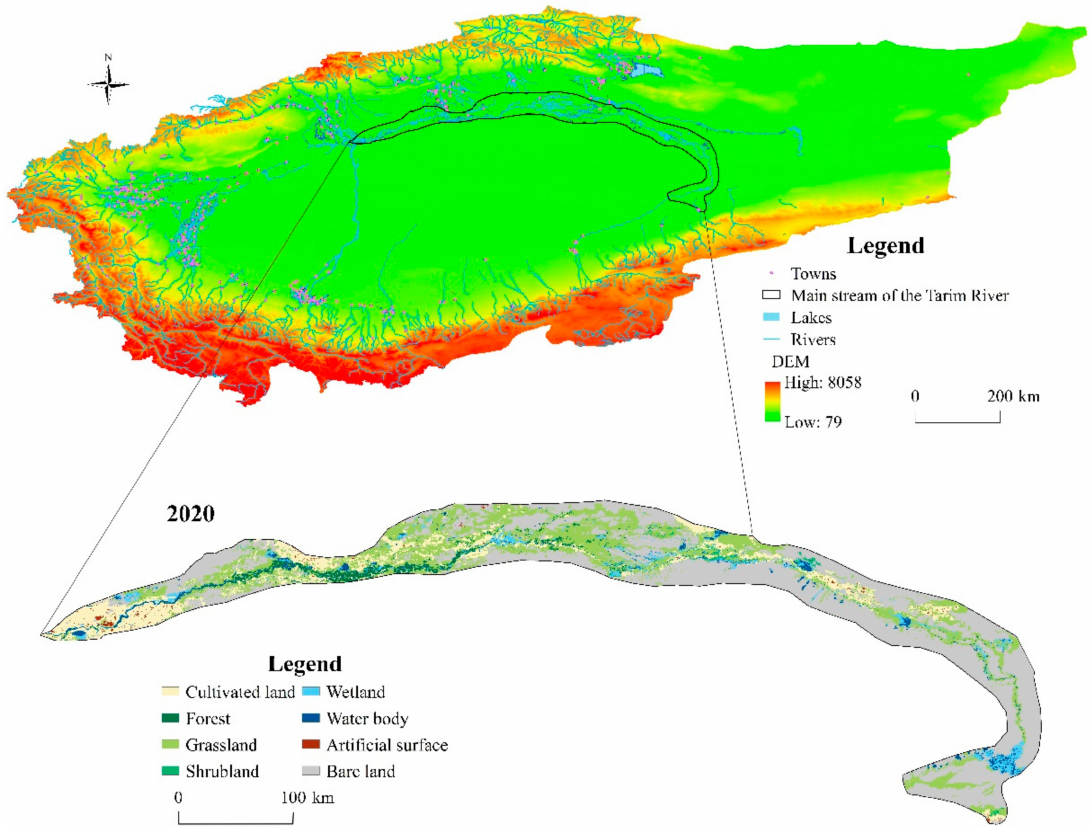
Figure 1. The spatial distribution pattern of land cover categories in the main stream of the Tarim River in